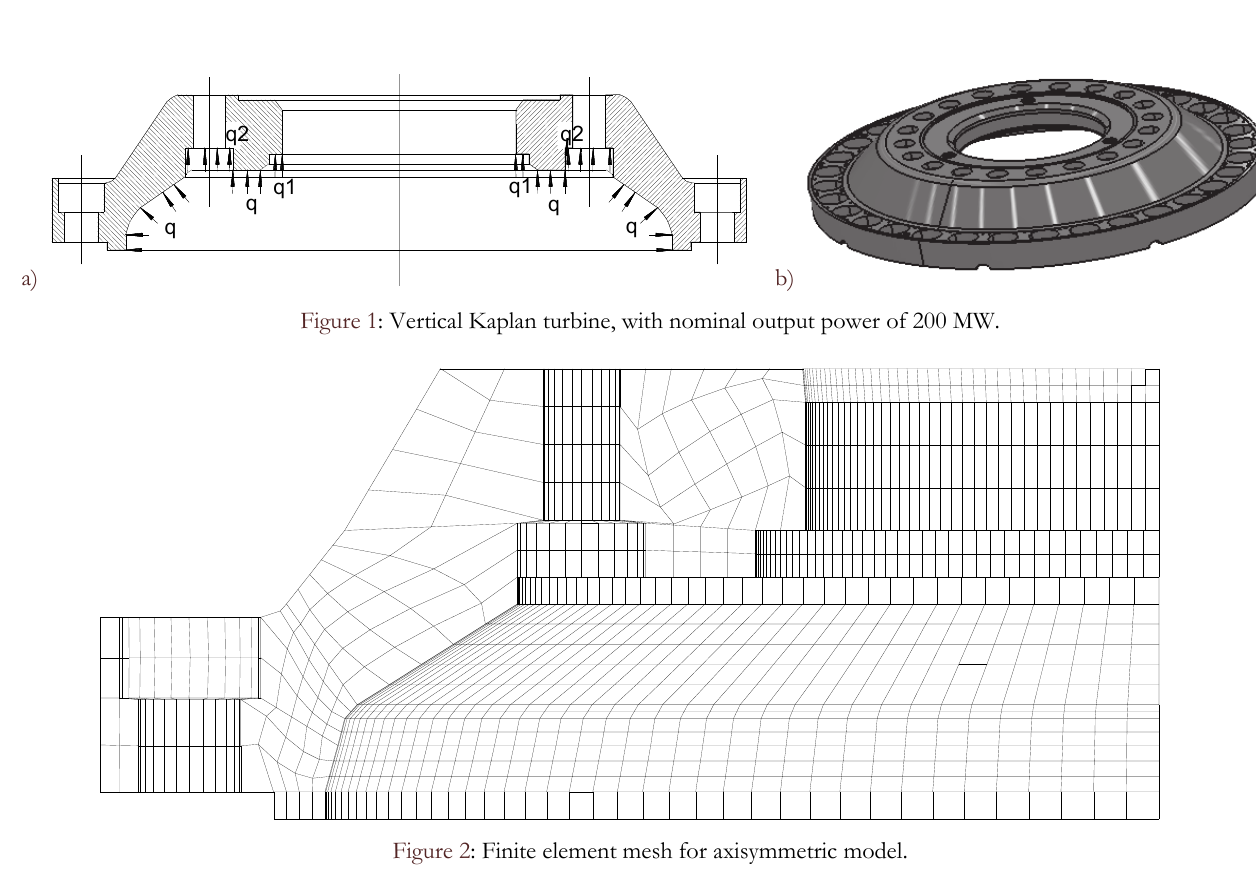
Figure 2: Finite element mesh for axisymmetric